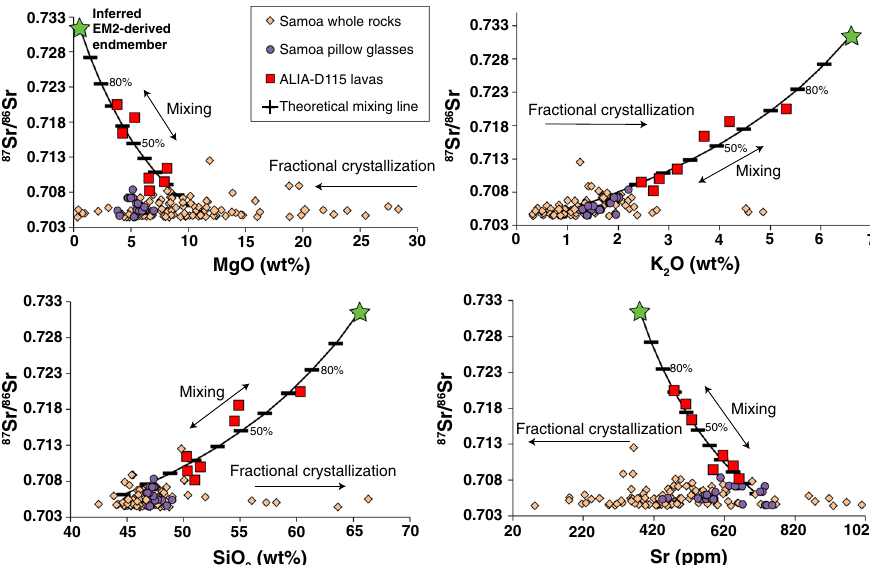
Fig. 3 87 Sr/ 86 Sr versus element concentration showing theoretical mixing curves of inferred endmember compositions. The direction of fractional crystallization is denoted by arrows. The green star denotes the EM2-derived mixing endmember composition (SiO 2 = 65.5 wt%, MgO = 0.5 wt%, Al 2 O 3 = 17.1 wt%, FeO = 3.8 wt%, CaO = 2.7 wt%, TiO 2 = 1 wt%, and Na 2 O + K 2 O = 11 wt%; see Supplementary Table 2), which is calculated in this study (see “ Methods ” ); the black hatched line shows the path of the calculated mixing curves, where each hatch increases by 10% mixing from the geochemically depleted ma fi c endmember to the more evolved EM2-derived endmember (black hatched line is derived from the same methodology as described brie fl y in Fig. 2 and in the “ Methods ” ). Mixing is clearly de fi ned by a curve with a non-zero slope, and is unlike the lavas that have been affected only by fractional crystallization (which have zero-slope trends). The ALIA-D115 lavas are represented by red squares, the other Samoan whole rock lavas by orange diamonds, and Samoan pillow glasses by purple circles. See Fig. 1 caption for data references; Samoa pillow glass data can be found in Workman et al. 6 . All errors bars smaller than